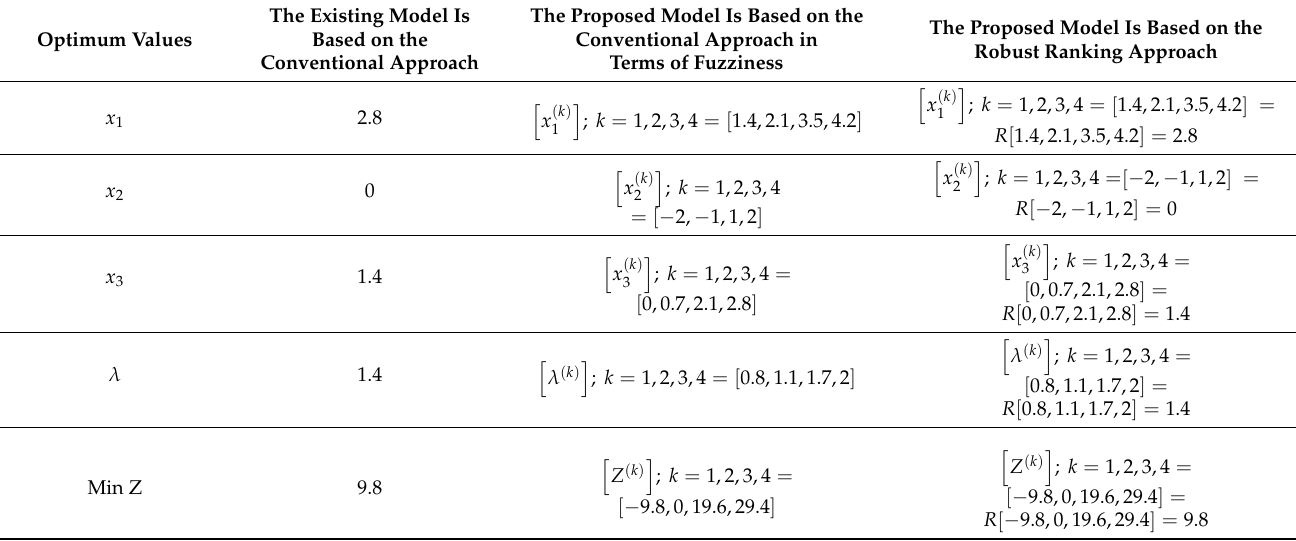
Table 2. Optimum results comparison of existing and proposed